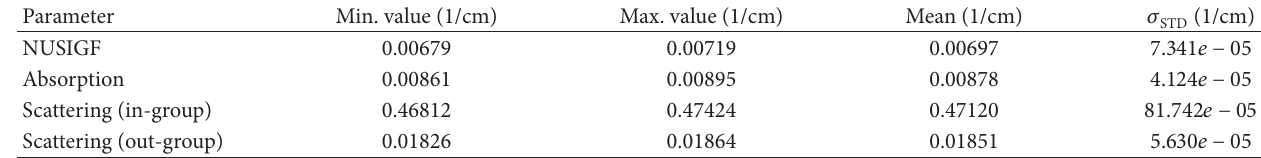
T 5: Uncertainty analysis of homogenized macroscopic cross-sections (fast group,